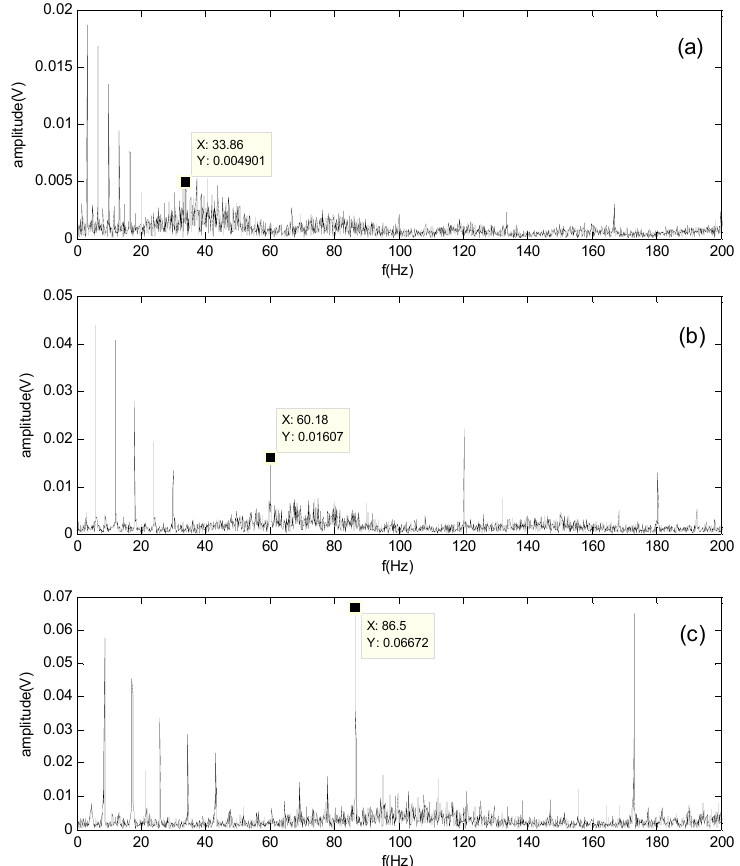
( c ) 1300 rpm. ( c ) 1300 rpm. Sensors 2016 , 16 , 897